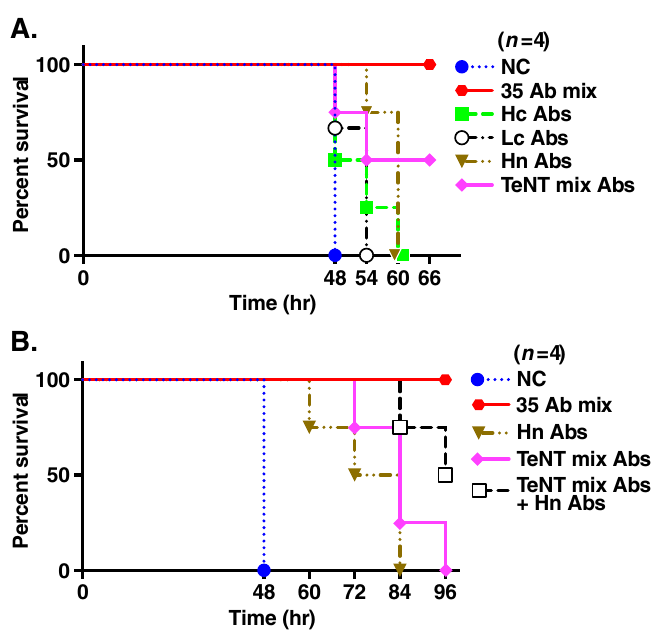
Figure 2. Hn- or TeNT mix–reactive antibodies in LCL supernatants neutralizes TeNT in mice. The protective effect of isolated antibody clones was analyzed by an in vivo TeNT-neutralization assay. We combined 0.5 ng human IgG-containing LCL supernatants from all 35 supernatants (35 Ab mix), 17 Hc-reactive supernatants (Hc Abs), 12 Lc-reactive supernatants (Lc Abs), 3 Hn-reactive supernatants (Hn Abs), or 3 TeNT mix–reactive supernatants (TeNT-mix Abs) prepared in a second screening experiment (Table 1). Then we mixed the supernatant mixture with 1 LD 50 (25 pg) of TeNT and administrated it to ddY mice. Mouse survival rates after administration are shown ( n = 4). NC negative control (medium). Statistical analysis was performed using Log- rank test.